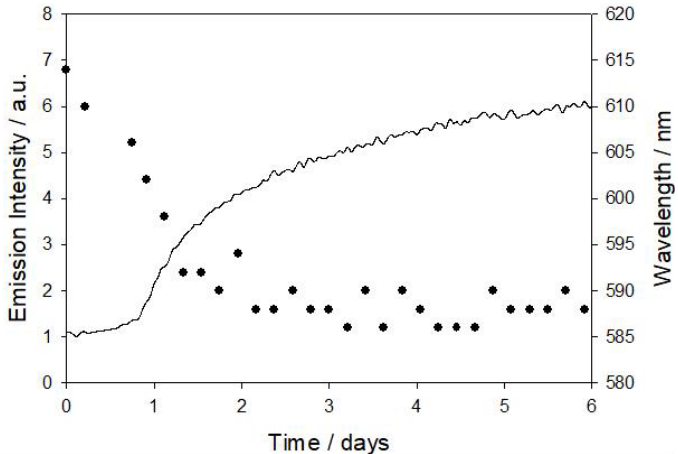
Figure 5. Continuous monitoring of the luminescence intensity (solid line) and maximum emission wavelength (full circles) of the [Ru(phen) 2 (4-Clp)] 2+ complex dissolved in ethyl cyanoacrylate during polymerization at room temperature. Table 4. Luminescence lifetimes of [Ru(phen) 2 (4-Clp)] 2+ in solution and immobilized into the poly(ethyl cyanoacrylate) matrix. The emission decays of the indicator dye have been fitted to the